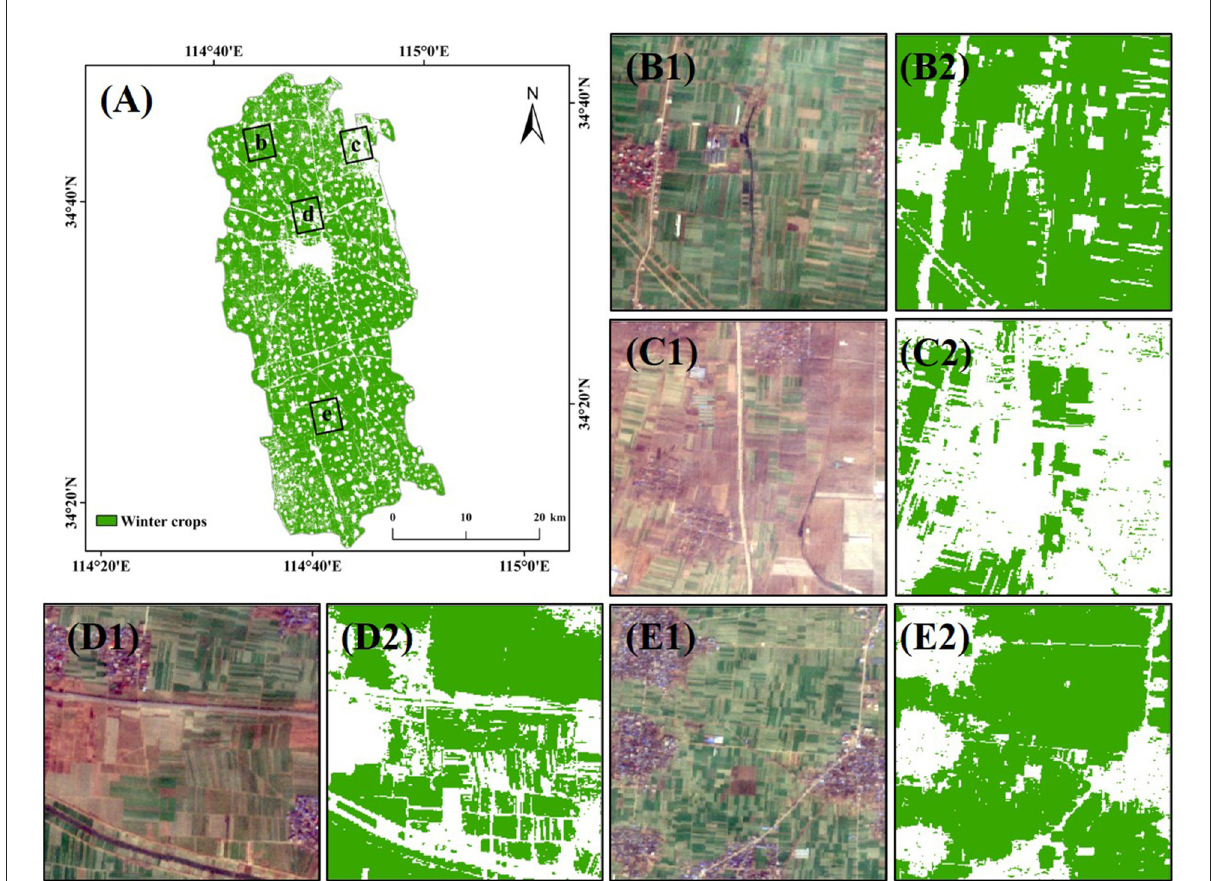
FIGURE13 (A) Distribution of winter crops in Qi County in 2020. Four regions, denoted as b, c, d, and e in (A) , were randomly selected. The 10-m resolution views from Sentinel-2 (December 19, 2019) are shown in (B1,C1,D1,E1) , and the zoom-in views in (A) for the four regions are shown in (B2,C2,D2,E2)